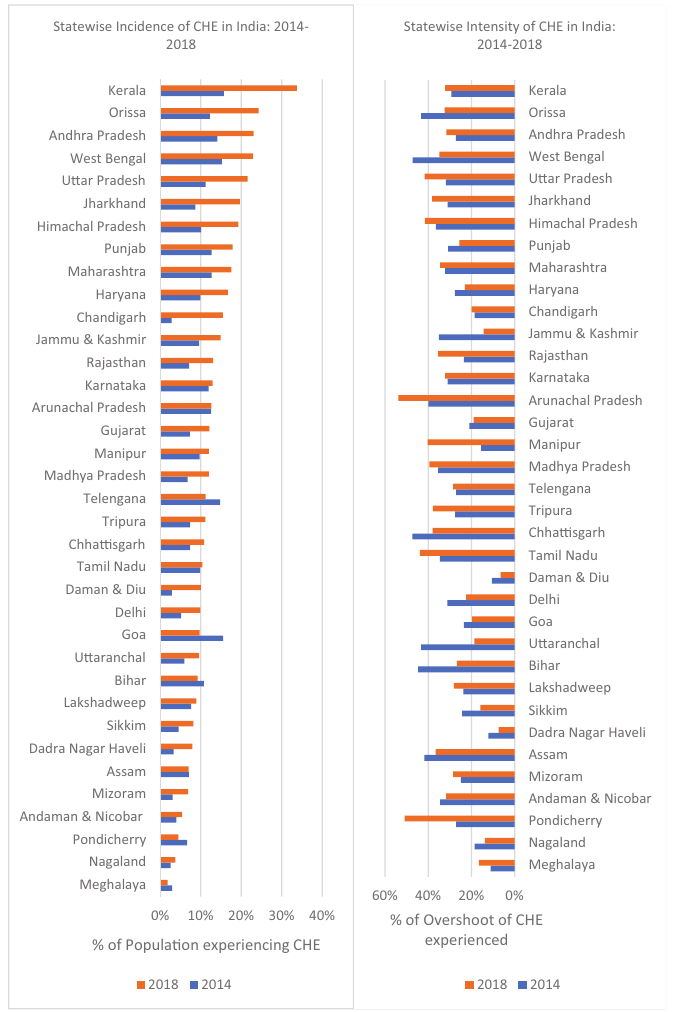
Figure 2. Incidence and intensity of CHE by